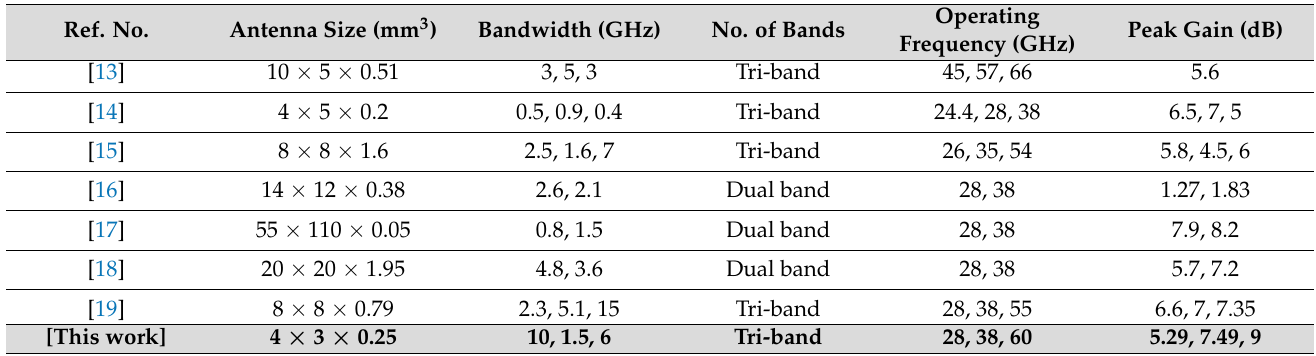
Table 2. Analysis of the planned study in comparison to relevant